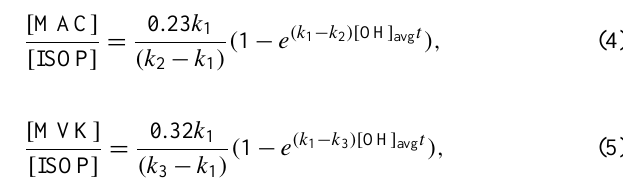
Fig. 4. The scatter plots of (a) m, p -xylenes vs. ethylbenzene and (b) i -butane vs. propane at TMS and TW.